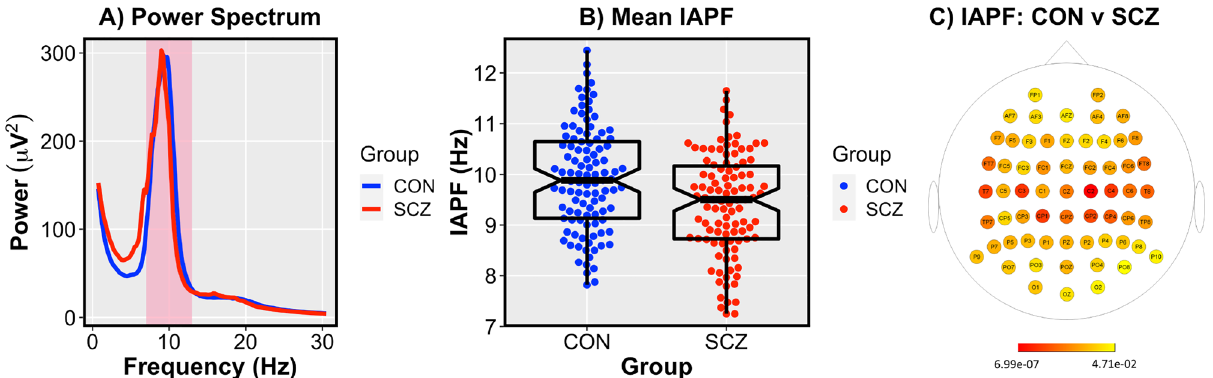
Figure 1. ( A ) Power spectrum from 0.5 to 30 Hz for CON (Blue) and SCZ (Red) groups (pink shaded area reflects 7.25–13 Hz range). A depiction of the log–log power spectrum is available in the supplemental material (Supplementary Fig. 1). ( B ) Mean IAPF across all electrodes was higher in CON (M = 9.91 Hz) compared to SCZ (M = 9.41 Hz; t = 3.71; p = 0.0003). Alternative depiction of the distribution of IAPF across groups is available in the supplemental material (Supplementary Fig. 2). ( C ) IAPF was lower in SCZ compared to CON across all electrode sites [FDR-corrected p < 0.05; colored electrodes reflect significance-level